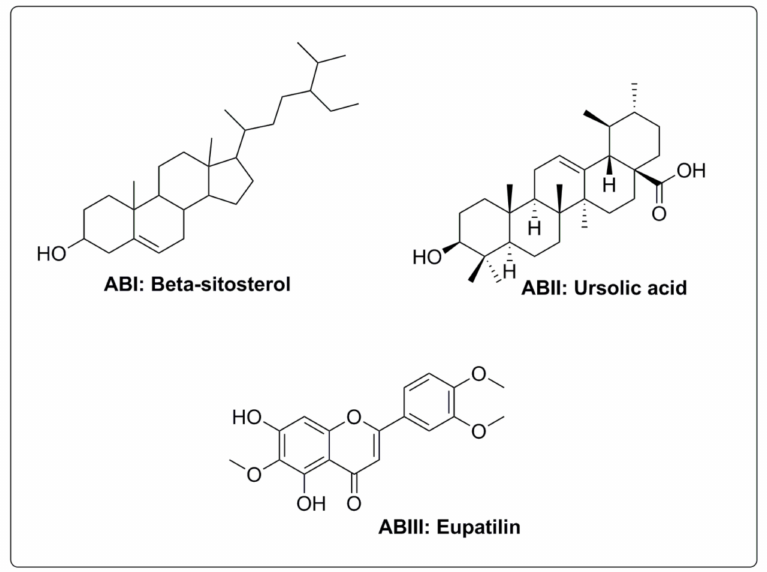
Figure 4. Isolated compounds from the pharmacologically-active fraction,